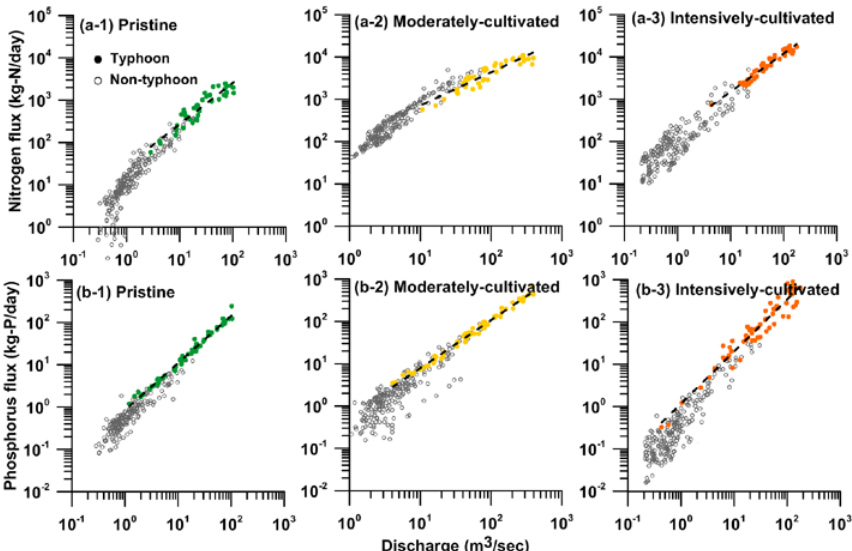
Fig. 8. The log-log graphs of observed (a) nitrogen and (b) phosphorus fluxes against discharge in the pristine (-1), moderately cultivated (-2), and intensively cultivated watersheds (-3). Solid and hollow circles represent typhoon and non-typhoon samples, respectively. The dashed lines stand for the power regression equation of typhoon